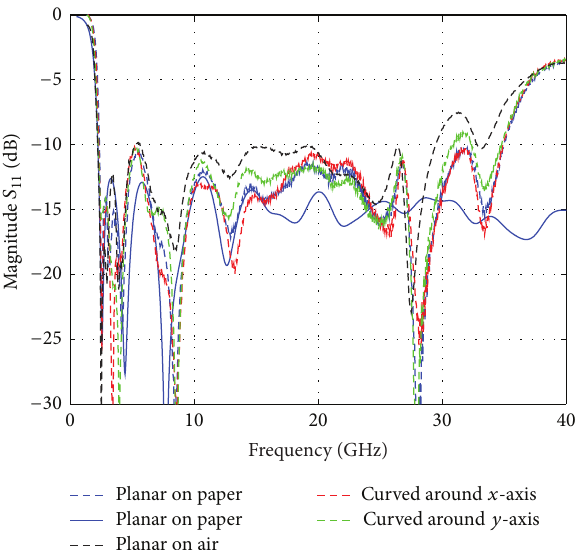
Figure 9: Magnitude of the reflection coefficient for the planar and curved antennas, as shown in Figure 8. Simulation: solid line. Measurement: dashed line.